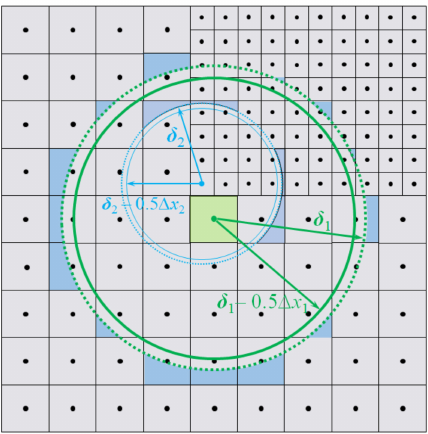
Figure 5. Volume correction for the collocation points inside the horizon.